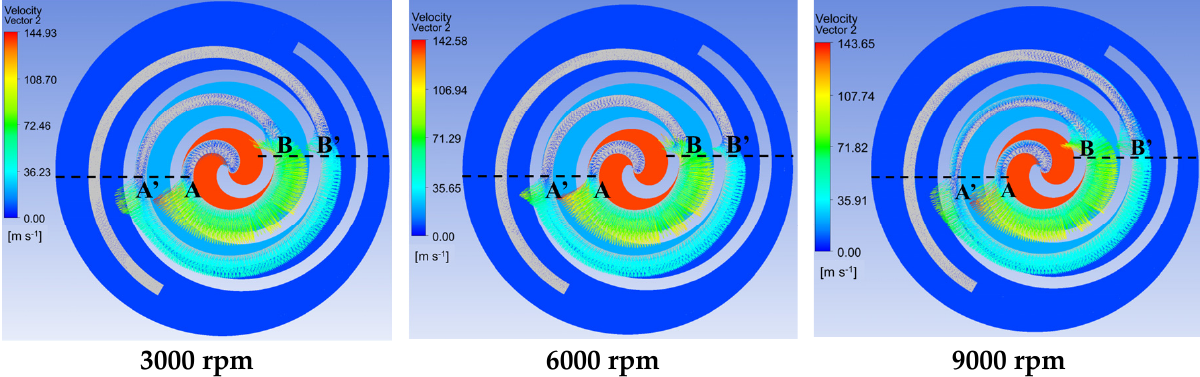
Figure 16. Variations in the maximum radial leakage velocity with the crank angle.